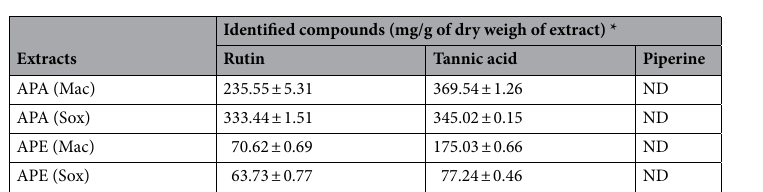
Figure 4. HPLC Chromatograms: ( A ); 70% ethanolic and ethyl acetate seed extracts of A. precatorius prepared from soxhlet extraction method, ( B ); 70% ethanolic and ethyl acetate seed extracts of A. precatorius prepared from maceration extraction method.